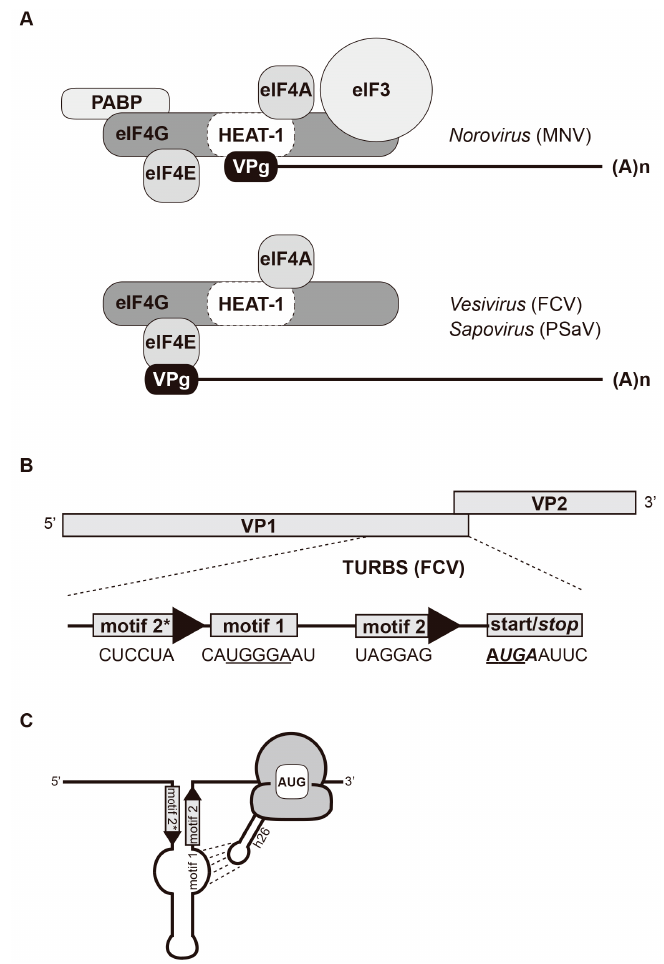
Figure 3. Interactions of caliciviral RNA and protein important in VPg-driven and reinitiation of translation. ( A ) Schematic representation of the interaction networks driving VPg-mediated